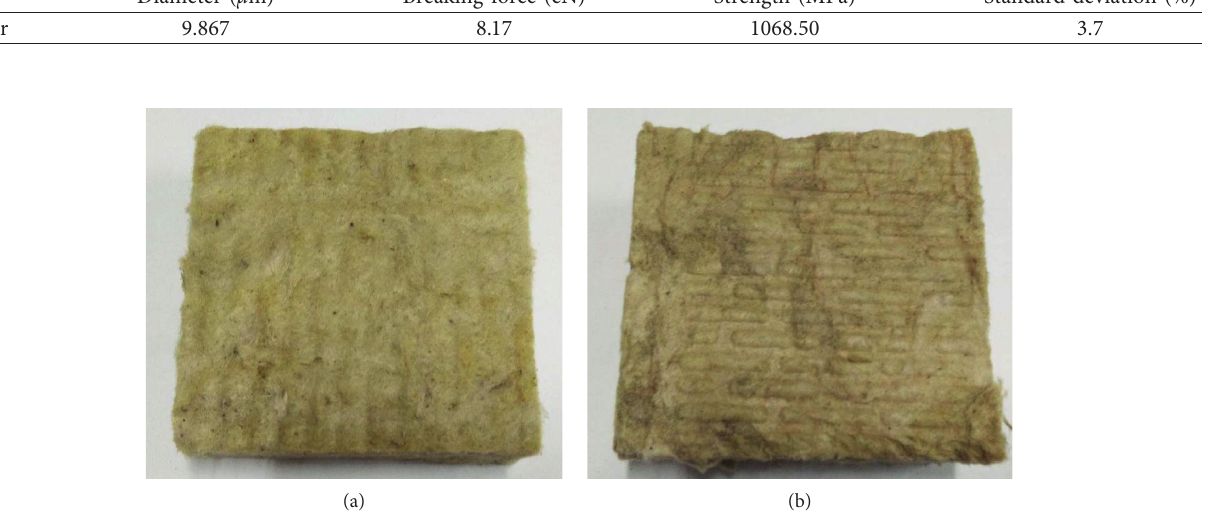
Figure 3: RWB samples with different diameter distributions: (a) mean diameter � 10.5 μ m; (b) mean diameter � 5.9 μ m.